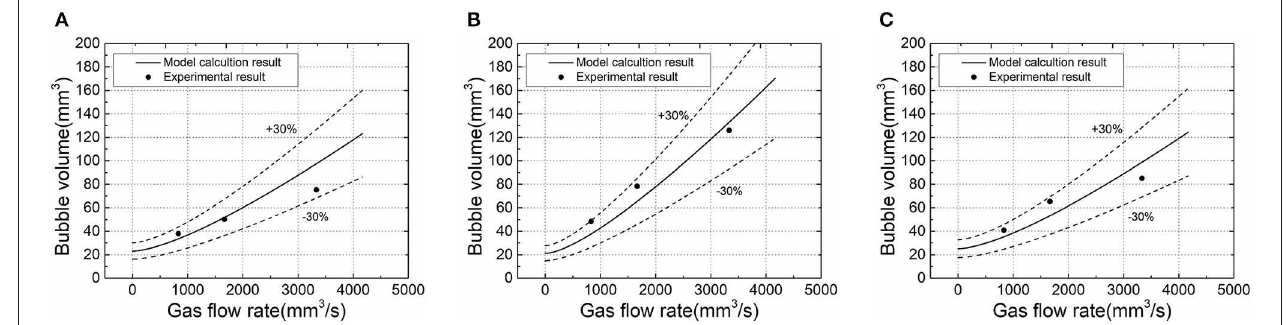
FIGURE 6 | Fitting experimental results with model calculation results under different working conditions. (A) Deionized water, liquid phase temperature 25 ◦ C. (B) Deionized water, liquid phase temperature 60 ◦ C. (C) 0.008g/l TiO 2 , liquid phase temperature 25 ◦